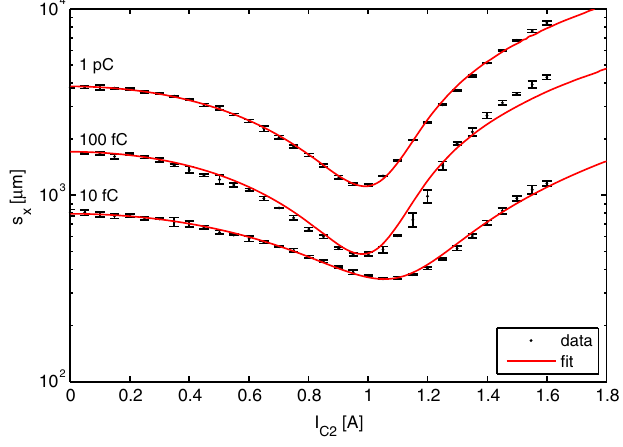
FIG. 7. Waist scans for different bunch charges.